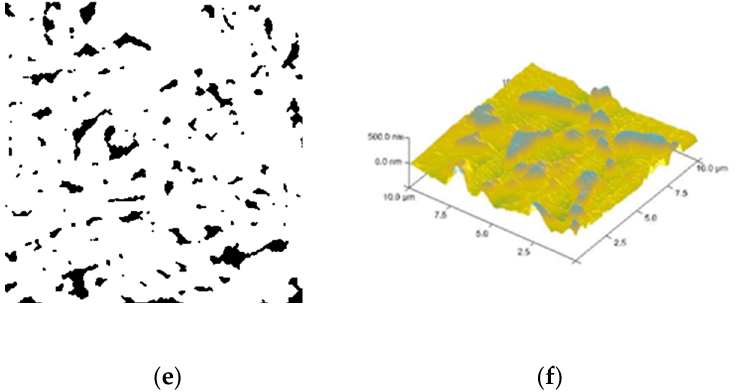
Figure 7. An image of the microstructure of samples heat-treated according to variant no. 1: ( a ) topography of the tested surface in semi-contact mode; ( b ) surface mapping with amplitude contrast; ( c ) surface topography in a 10-degree colour scale; ( d ) comparative control image with a limited continuous colour palette; ( e ) binary image after digitization of the austenitic phase; ( f ) 3D view of the sample surface.